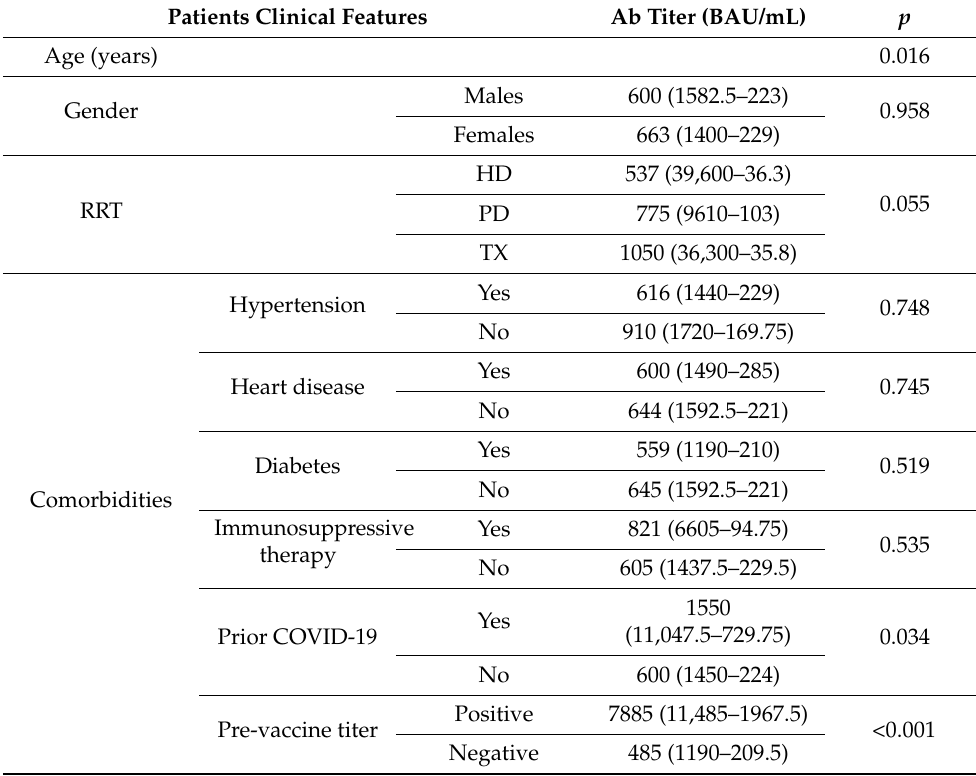
Table 4. Antibody titers in responders expressed as median (interquartile